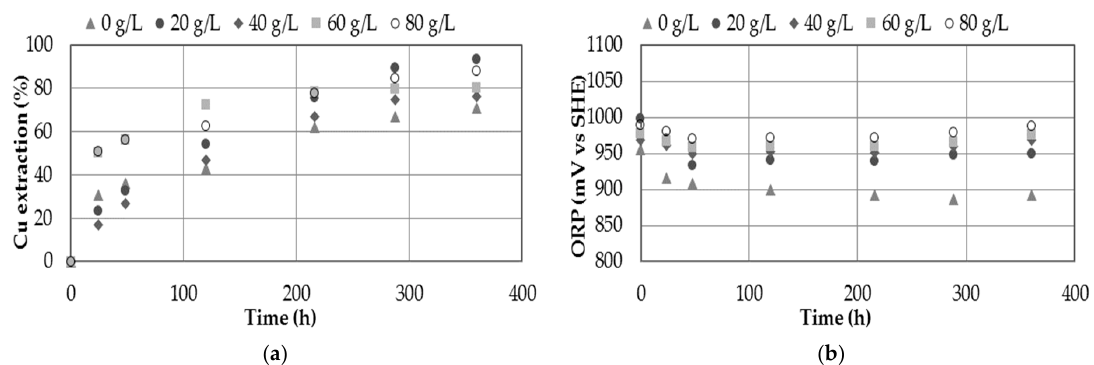
Figure 6. ( a ) Copper extraction (%) vs. time (h) at di ff erent chloride concentration: 0, 20, 40, 60 and 80 g / L. ( b ) Redox potential (mV) vs. time (h) at di ff erent chloride concentration: 0, 20, 40, 60 and 80 g / L. Experimental conditions: [NaNO 3 ] = [H 2 SO 4 ] = 0.7 M, water as dissolvent, 45 ◦ C and sample A.